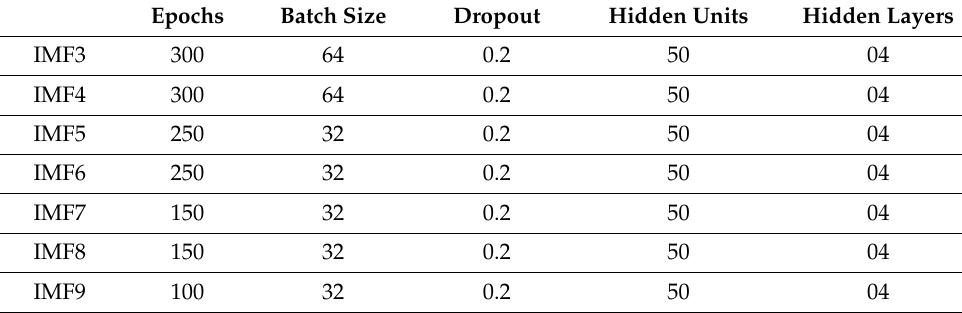
Table 8. Hyper-parameters of the EEMD-LSTM